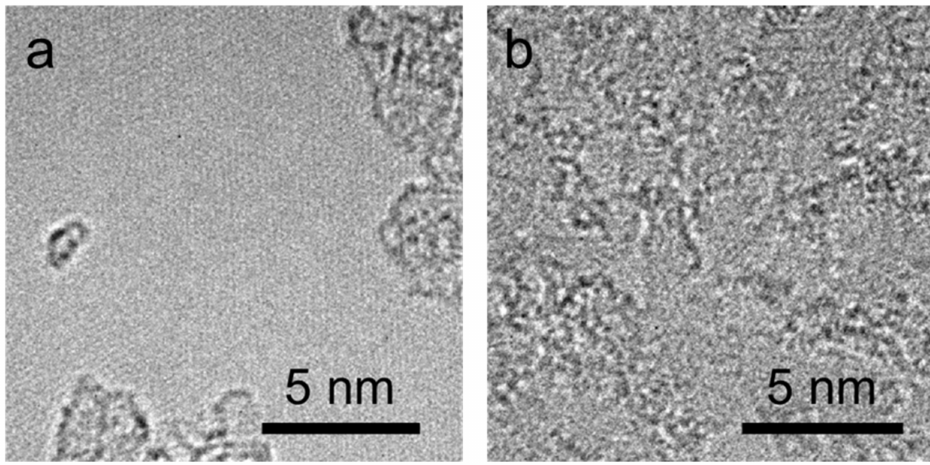
Figure 7. HRTEM images of ( a ) graphene and ( b )